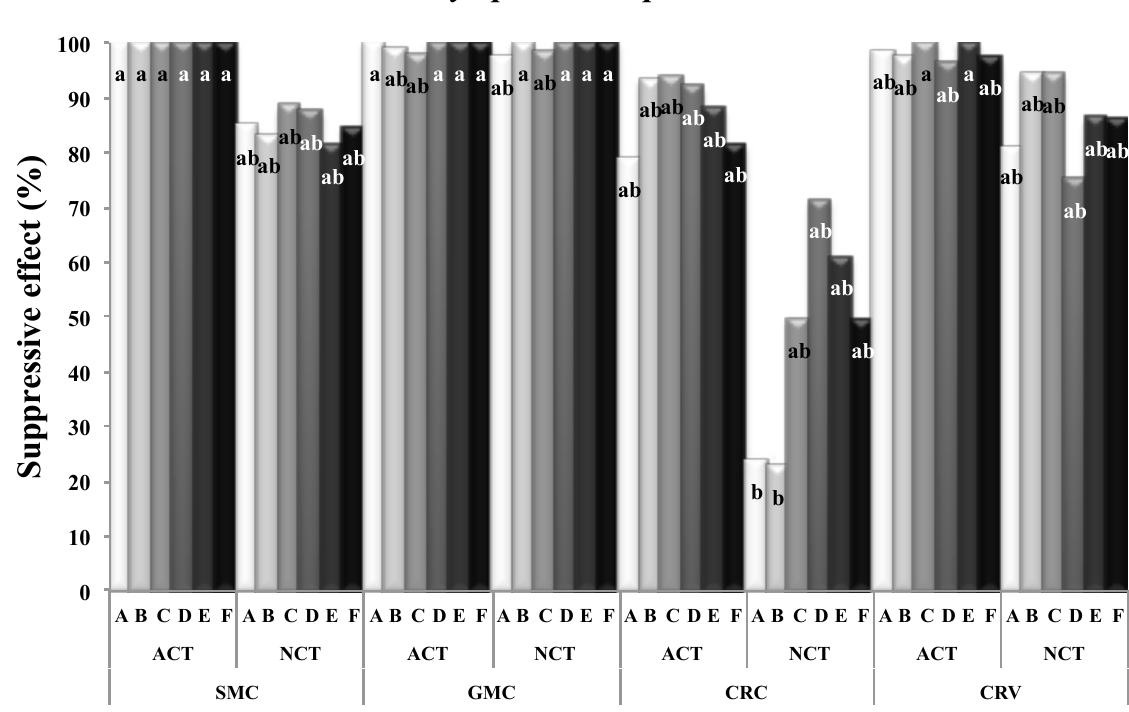
Figure 1. Inhibition percentages of Phytophthora capsici colonies in agar plates containing medium augmented with aer - ated compost tea (ACT) and non-aerated compost tea (NCT) from spent mushroom compost (SMC), grape marc compost (GMC), crop residues compost (CRC) and crop residues vermicompost (CRV). Compost teas were obtained in ratio 1:3 w:v and incorporated into PDA to concentrations of 5% (A), 10% (B) and 15% (C) v:v and ratio 1:4 w:v and incorporated into PDA to concentrations of 5% (D), 10% (E) and 15% (F) v:v. Different letters indicate significant differences according to One-Way ANOVA tests ( P